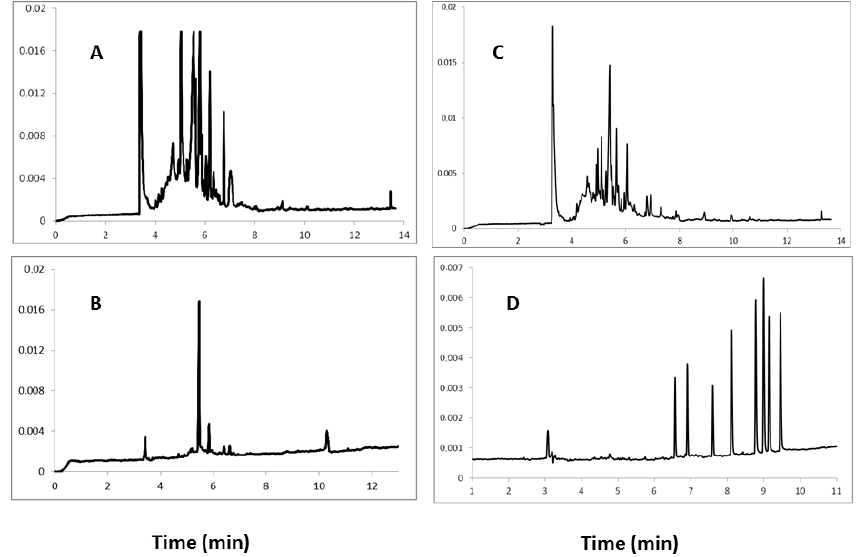
cartridges and elution 18 B O and 50 mM 2 4 7